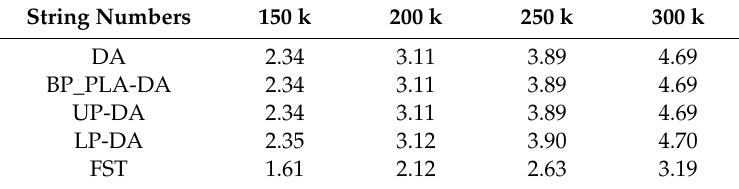
Table 4. EN-WIKI storage spaces (MB).